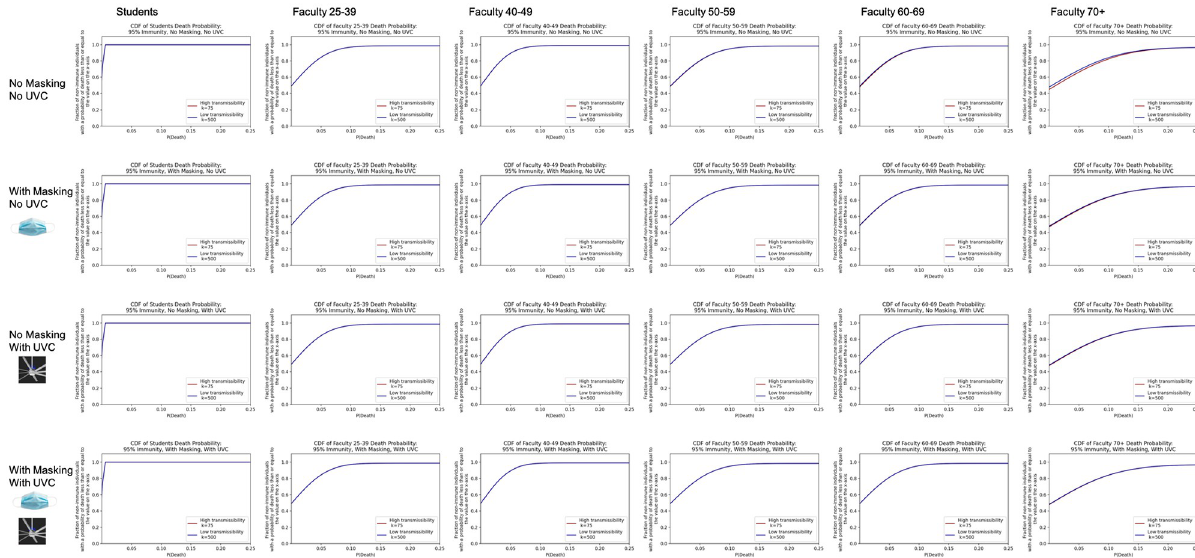
Fig 11. Cumulative density function for the probability of death by age group given 95% immunity. Note that all students are lumped together into one age group, assumed to be the 18–24 age group.